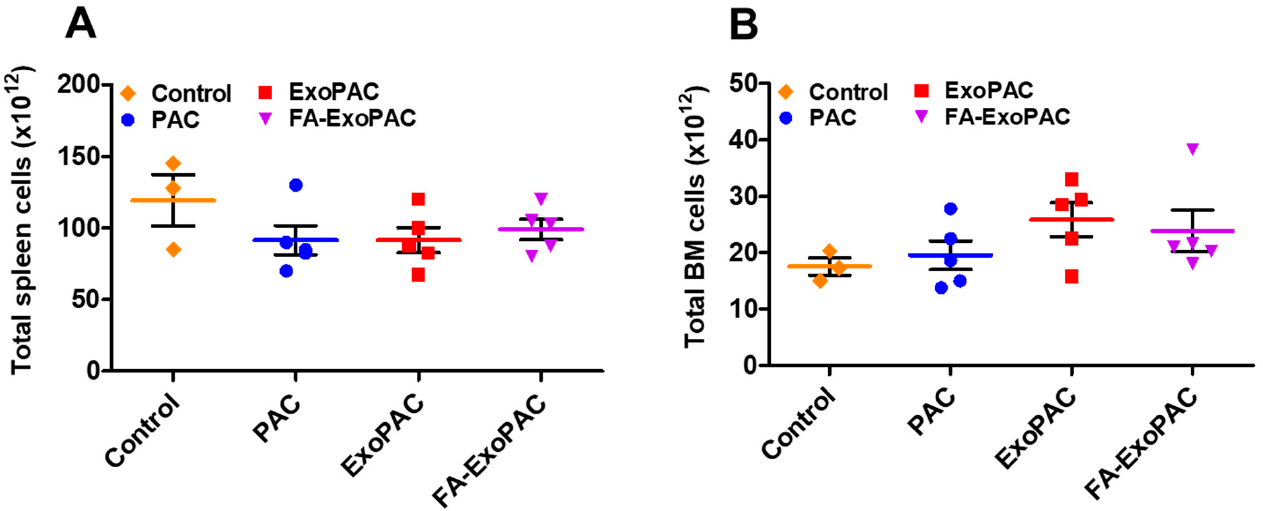
Figure 6. Potential immunotoxicity of PAC and FA-ExoPAC. Female C57BL/6 mice were treated with Exo, PAC and FA-ExoPAC for four weeks. At euthanasia, spleen and bone marrow cells were collected. Live splenic ( A ) and bone marrow ( B ) cell counts were performed by trypan blue exclusion.